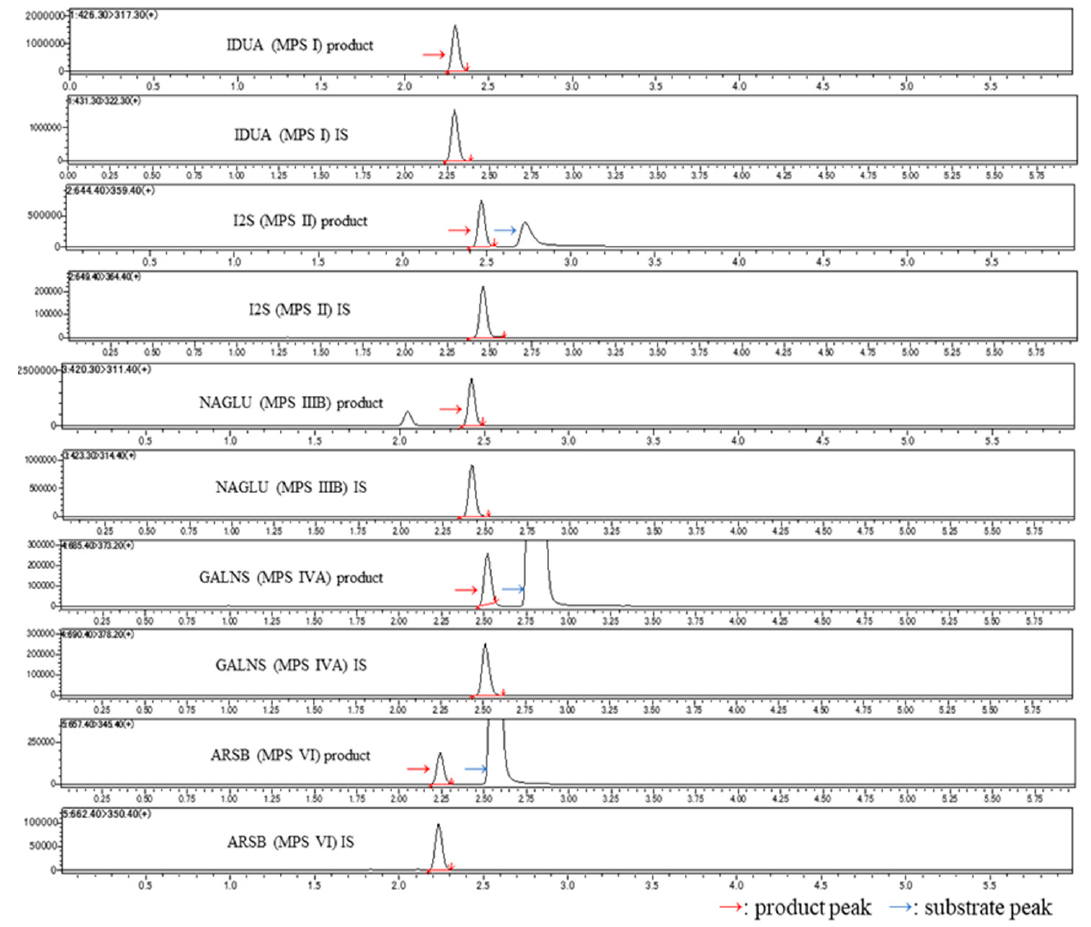
Figure 1. Chromatogram of substrate, reaction product, and internal standard (IS) for each mucopolysaccharidosis (MPS) enzyme. Red arrows represent the chromatogram for the product of enzyme reaction and blue arrows represent that for the substrate.